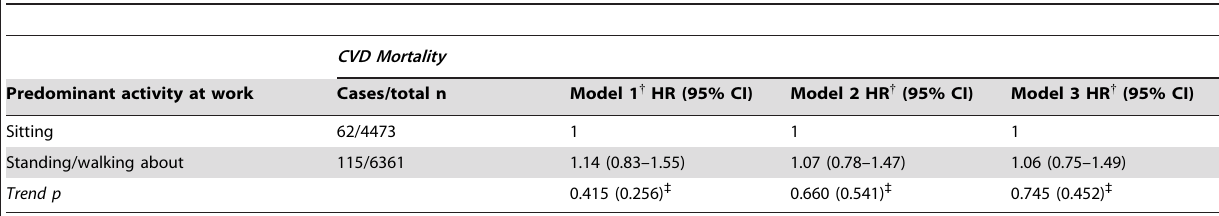
Table 4. Cox regression models for main activity while at work and cardiovascular mortality in men and women aged $ 40 years combined who were in employment at baseline (n=